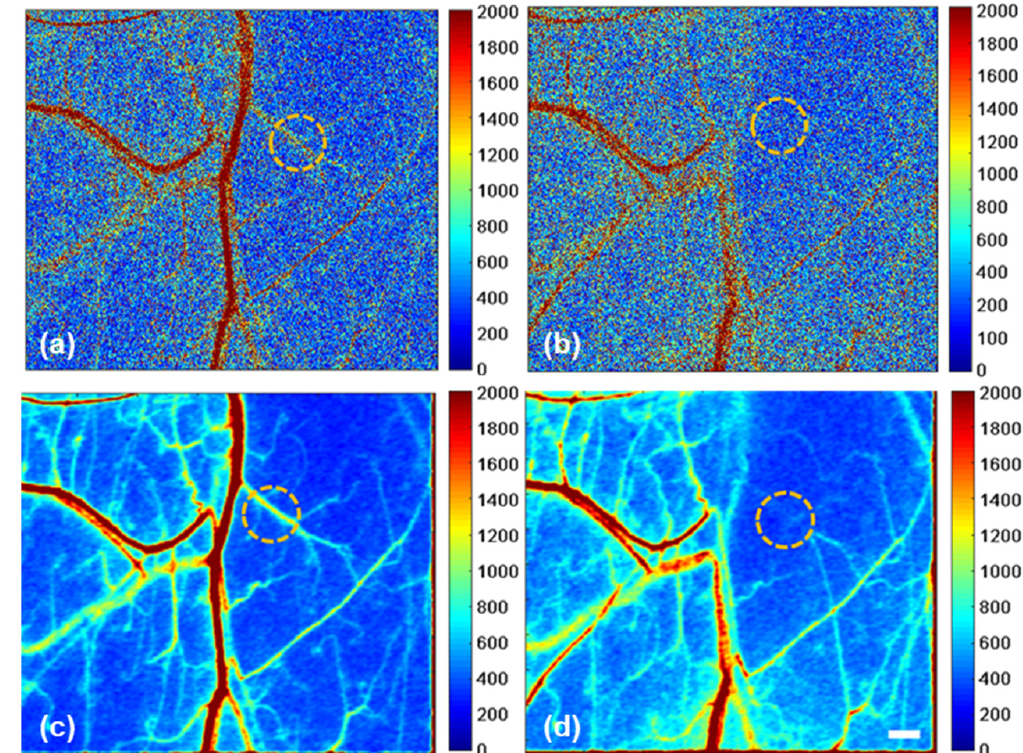
Figure 10. SFI images processed by the tLSCI without/with introducing the ADF (scale bar = 100 µm). ( a ) Before irradiation (tLSCI), ( b ) after irradiation (tLSCI), ( c ) before irradiation (with the ADF), ( d ) after irradiation (with the ADF).